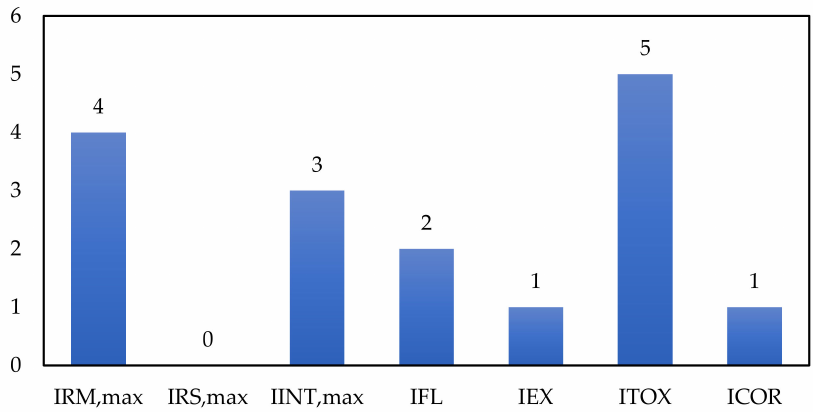
Figure 2. Contribution of CSI